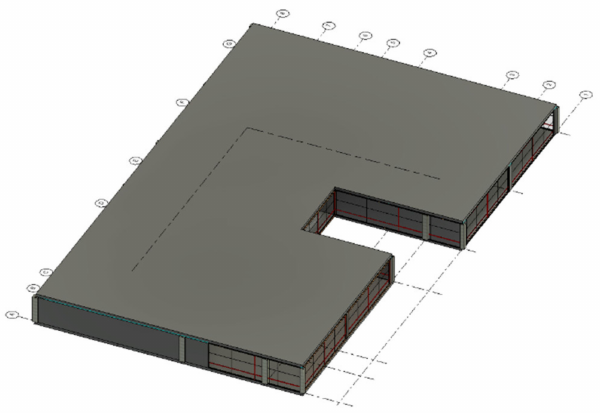
Figure A4. Case Study—U shape BIM model.